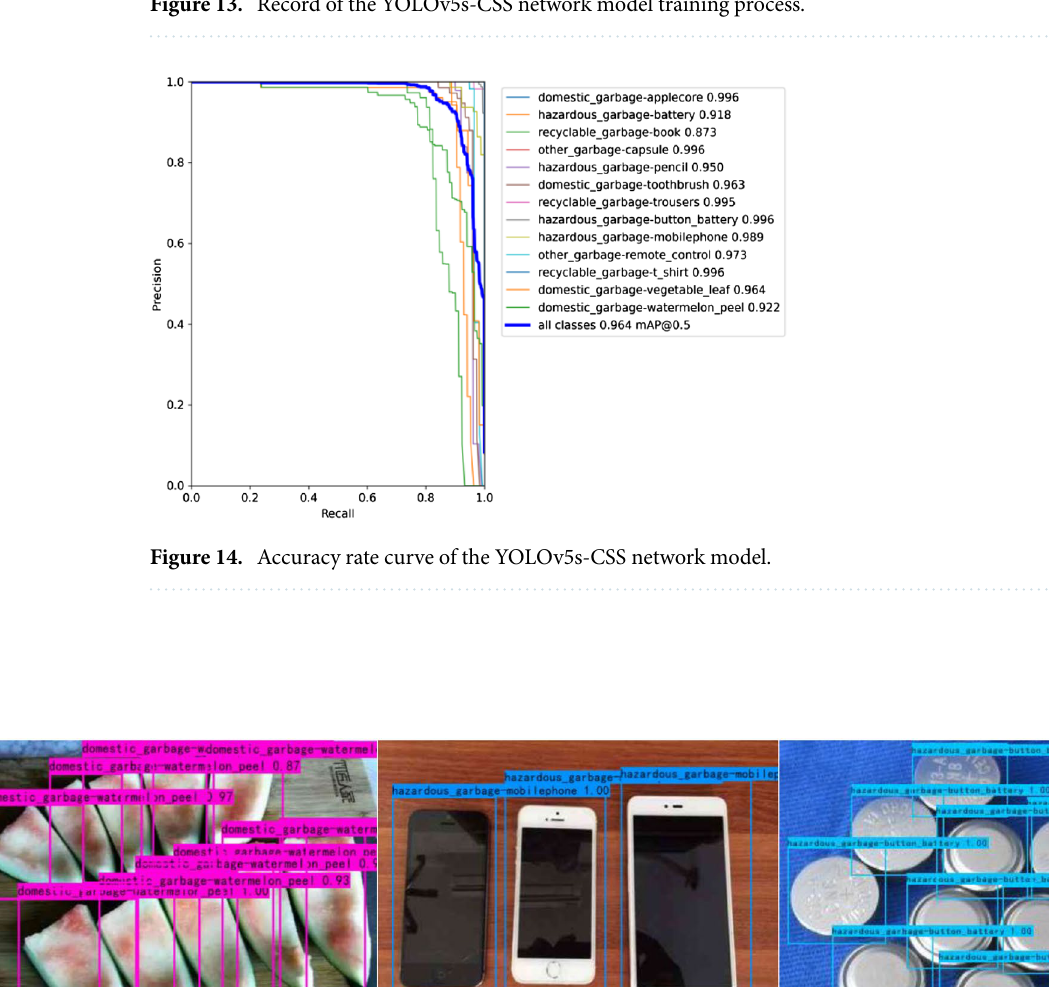
Figure 13. Record of the YOLOv5s-CSS network model training process.